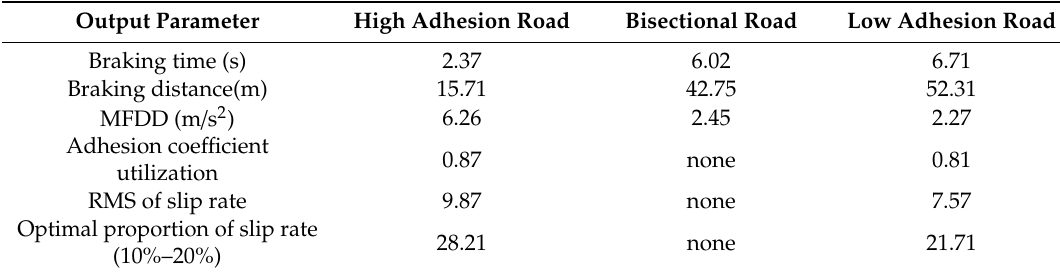
Table 2. Output parameters of bench test.